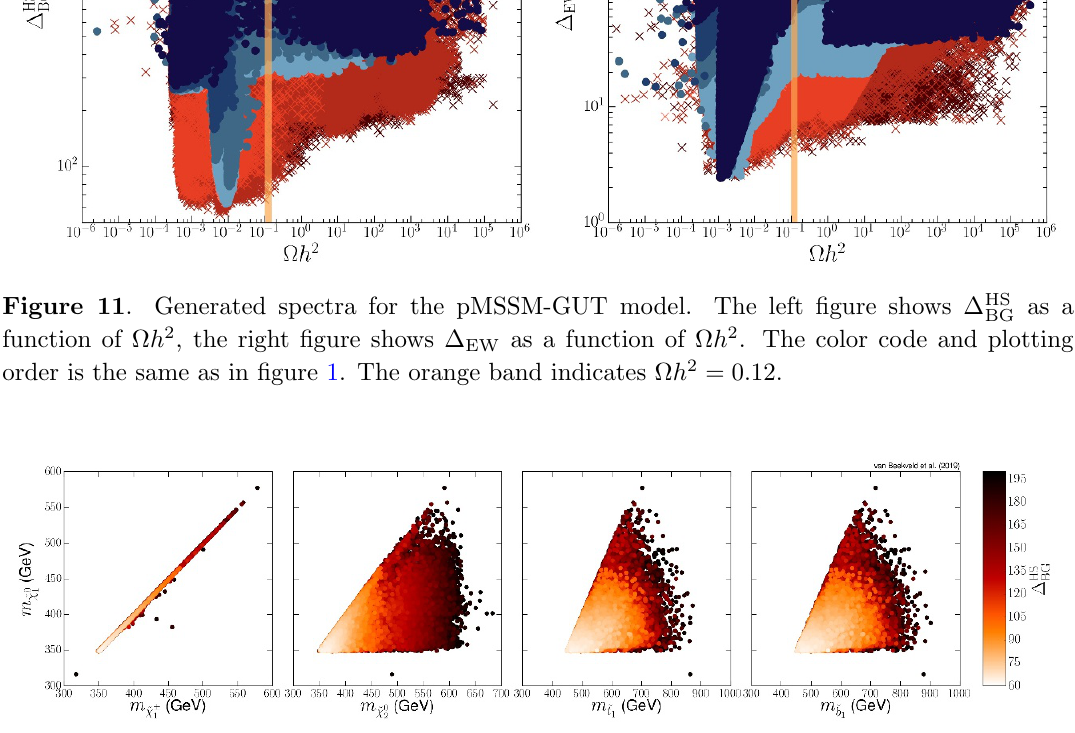
, ~ (cid:31) 0 , ~ t 1 and ~ b 1 against m in GeV. The value for (cid:1) HS ~ (cid:31) 0 1 2 1 < 200. The spectra with lower values for (cid:1) HS BG